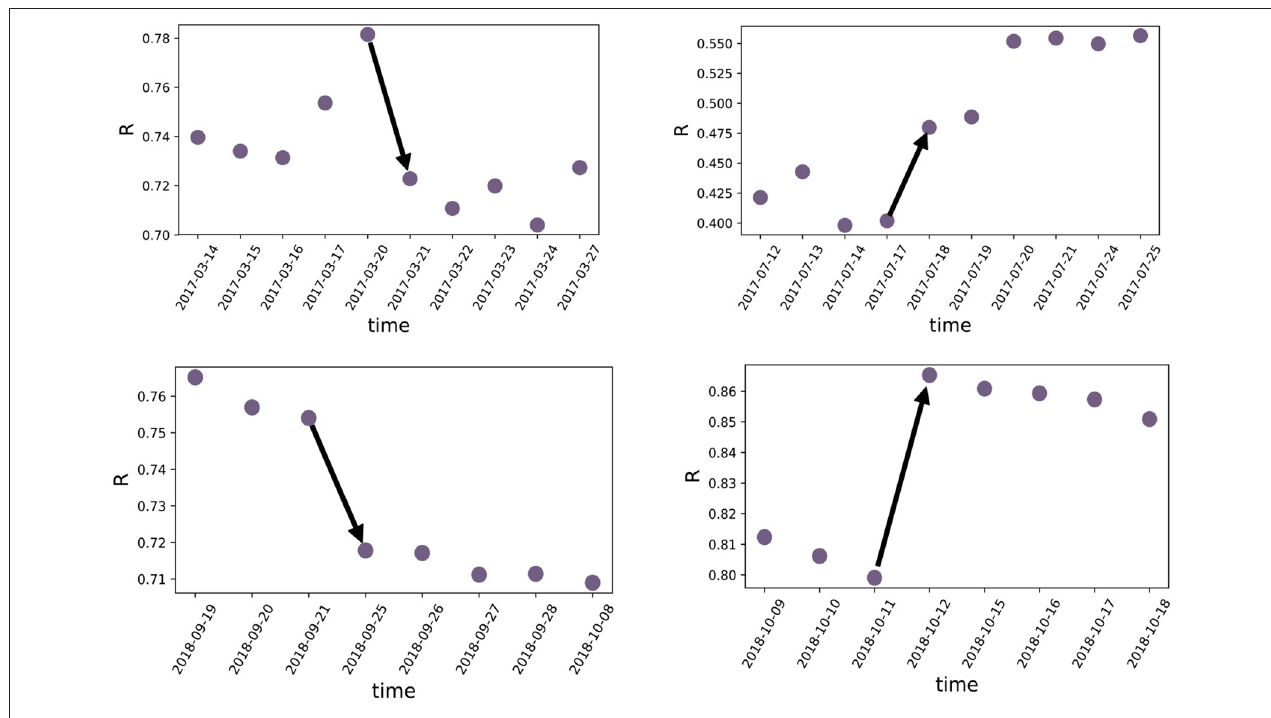
FIGURE 9 | Impacts of economic policy.